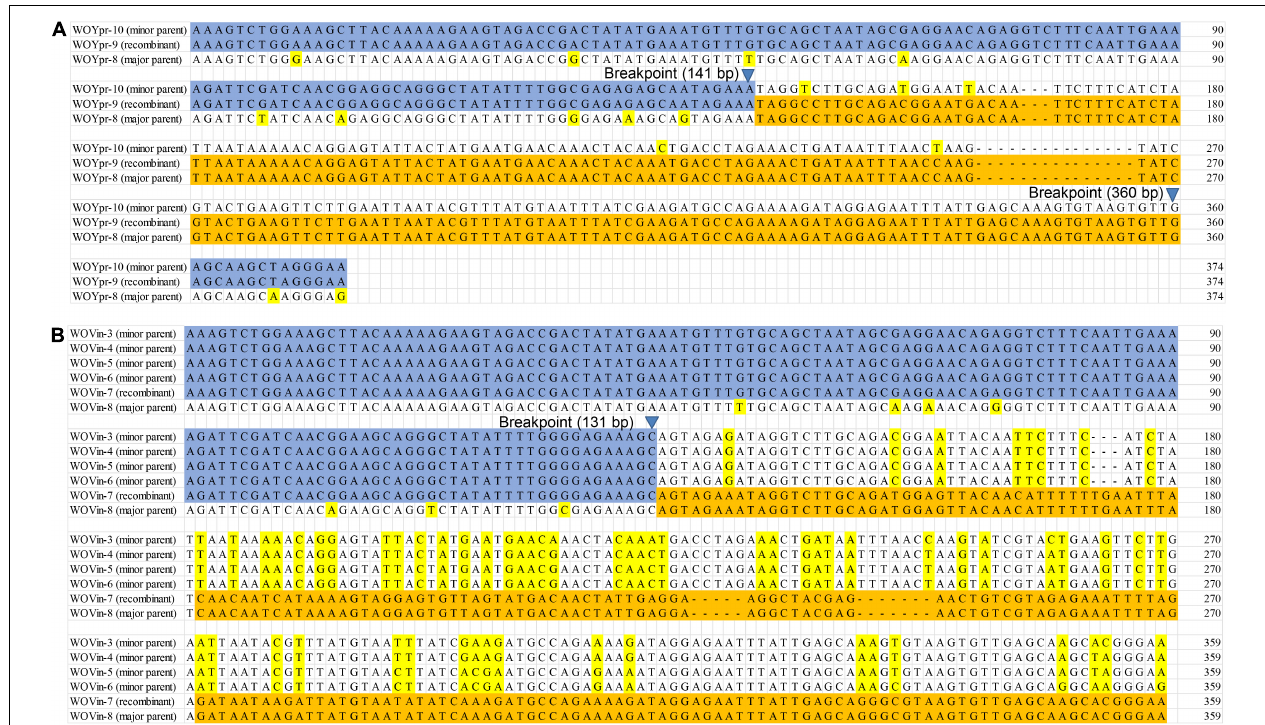
FIGURE 3 | Recombination events of the orf7 gene between WOYpr-8 and WOYpr-10 resulting in recombinant WOYpr-9 (A) and among WOVin-8 and WOVin-3, WOVin-4, WOVin-5, and WOVin-6 resulting in recombinant WOVin-7 (B)